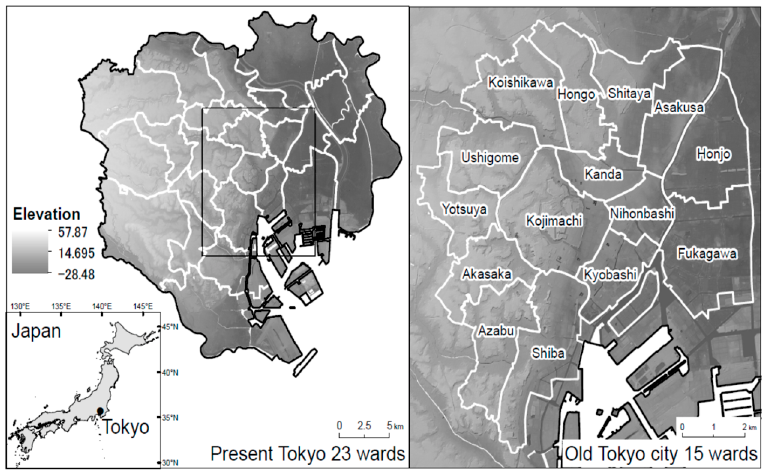
Figure 1. Study area. Old Tokyo city’s 15 wards (1889–1932) located in center of present Tokyo’s 23 wards (1947–present).